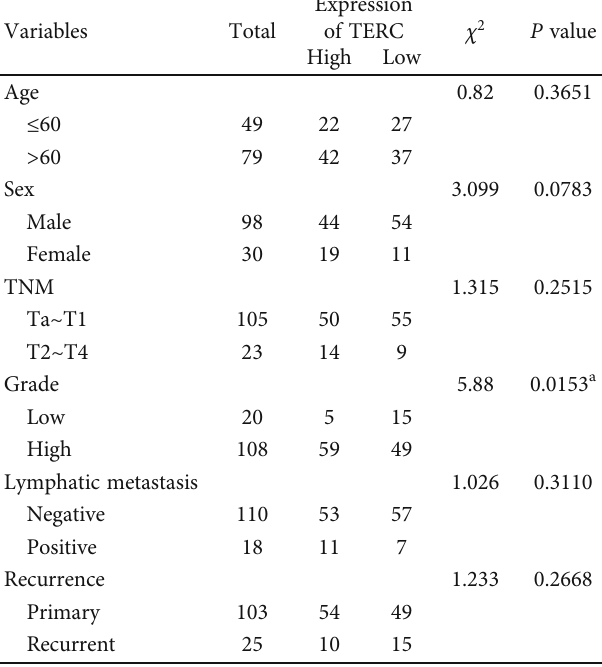
Table 4: The characteristics of bladder urothelial carcinoma